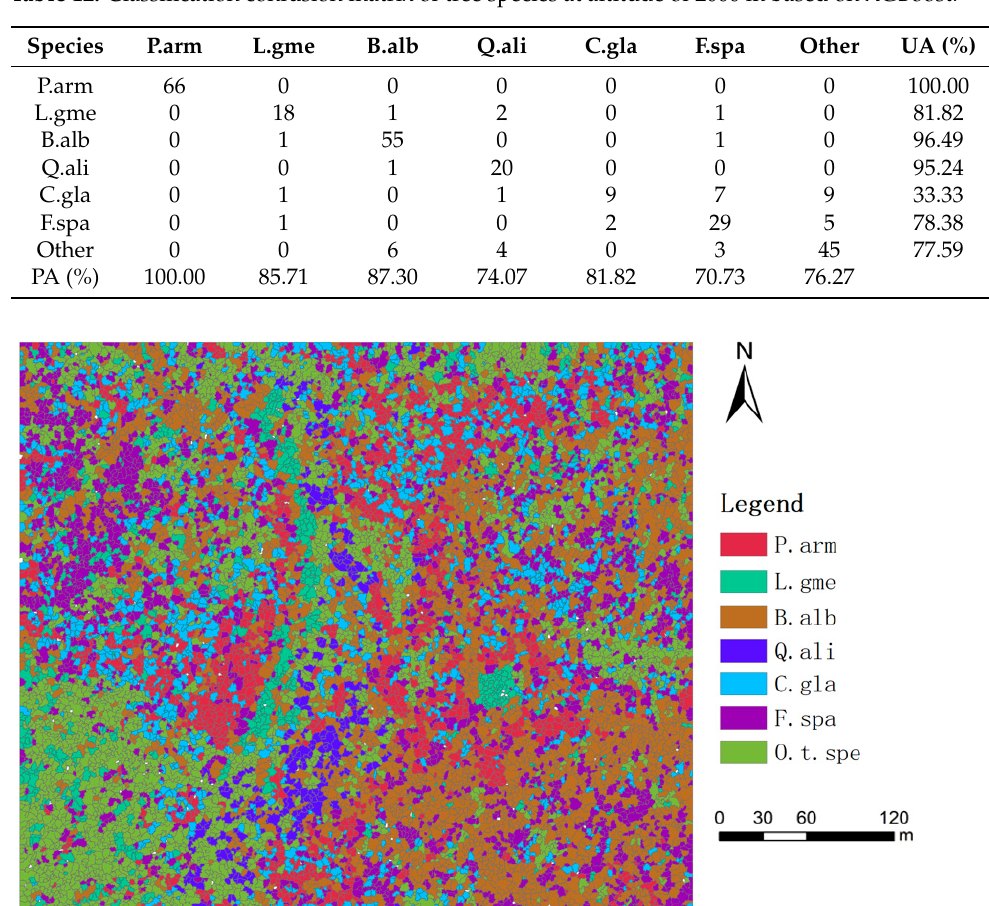
Figure 7. Classification results of tree species at altitude 2000 m based on XGBoost.